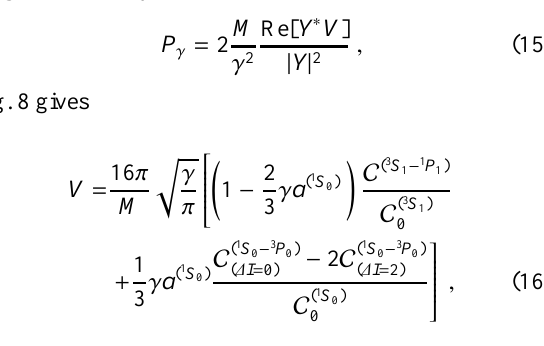
Fig. 7. Diagrams for strong (M1 at this order) np arrowed lines are nucleons, the wavy lines photons, and the X stands for the deuteron interpolating field. The bubble sum is from nonperturbative strong scattering.